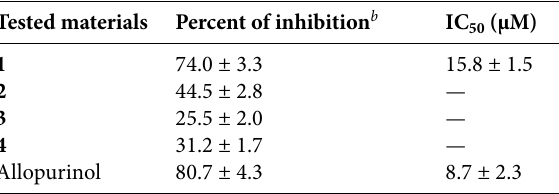
Table 3. Inhibition of XO by the tested materials. Tested materials